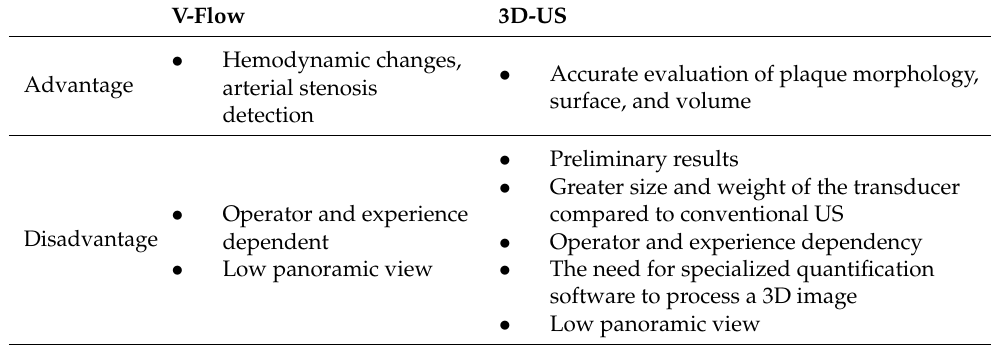
Table 3. V-flow and 3D-US advantages and disadvantages for detection of carotid